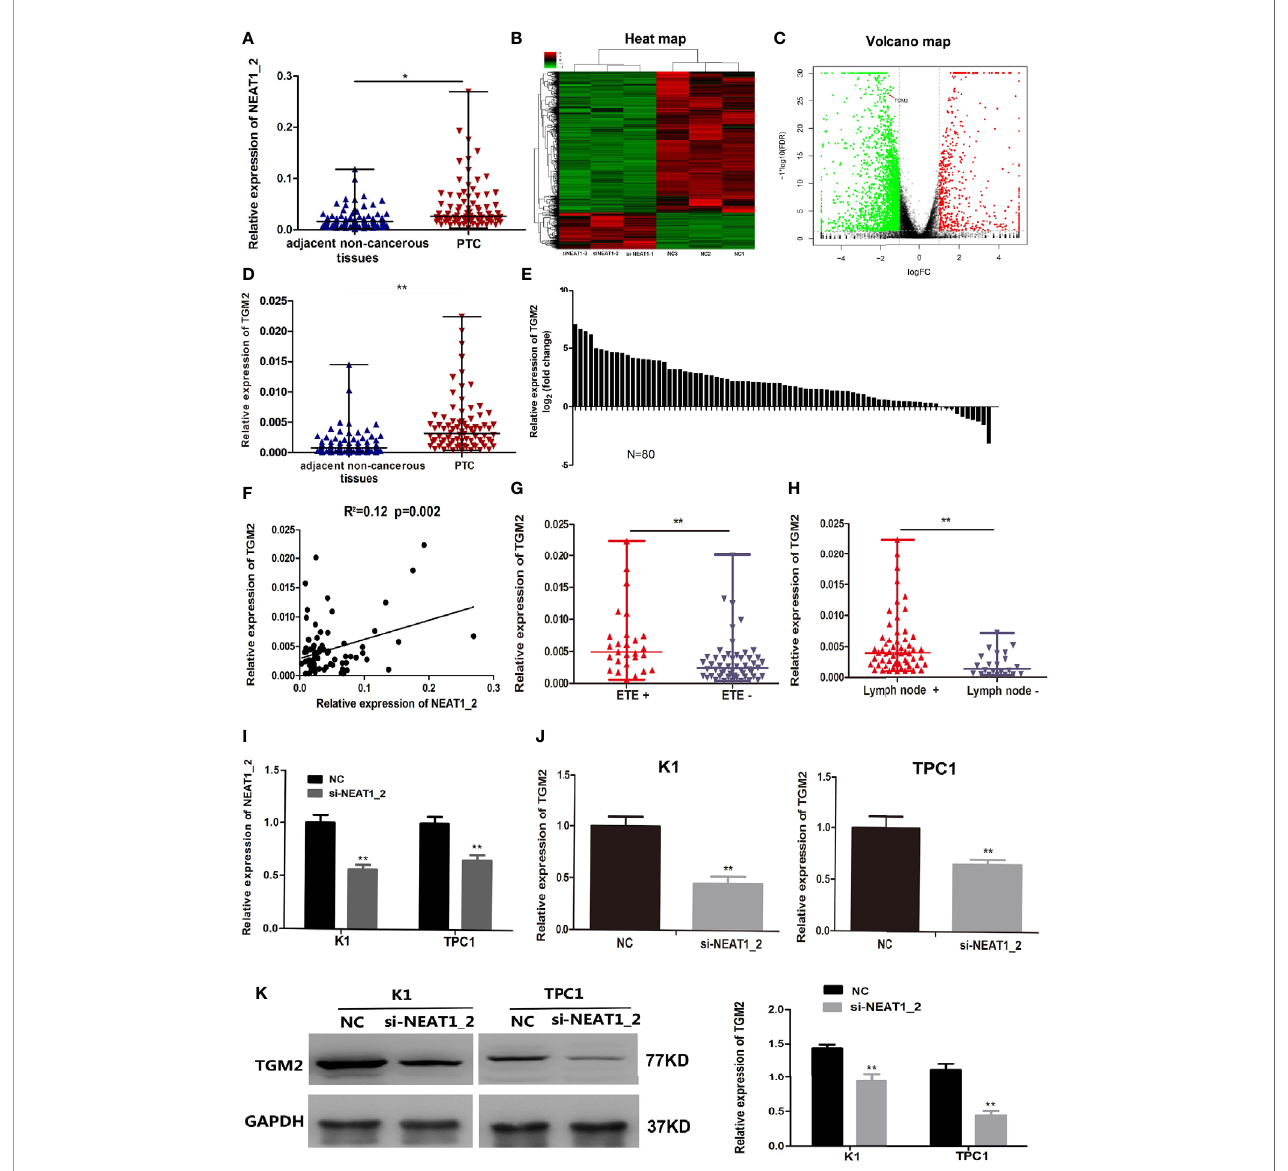
FIGURE 1 | NEAT1_2 expression was high and could regulate TGM2 in PTC. (A) The relative expression levels of NEAT1_2 in 80 pairs of PTC tissues and adjacent non- cancerous tissues, as determined using qRT-PCR. The Wilcoxon signed-rank test was used to analyzed the differences between the two groups; data are presented as the median with a range. *P < 0.05. (B) Heat map of differentially expressed mRNAs (615 upregulated and 2364 downregulated) in K1 cells transfected with si-NEAT1_2 and NC. (Fold change ≥ 2, P < 0.05). (C) Volcano plots were constructed based on the sequencing results of the differentially expressed mRNAs between K1 cells transfected with si-NEAT1_2 and NC. The red points represent differentially upregulated genes, and green points represent downregulated genes (Fold change ≥ 2, P < 0.05). A red arrow indicates TGM2 in the plots. (D) The relative expression levels of TGM2 in 80 pairs of PTC tissues and adjacent non-cancerous tissues, as determined using qRT-PCR. The Wilcoxon signed-rank test was used to analyzed the differences between the two groups; data are presented as the median with a range. **P < 0.01. (E) The fold change of TGM2 expression between PTC and corresponding adjacent non-cancerous tissues. (F) Pearson ’ s correlation analysis was performed to analyze the correlations between NEAT1_2 and TGM2 expression in PTC tissues (R 2 = 0.15, P < 0.05). (G) TGM2 expression in the extrathyroidal extension positive (n = 27) and extrathyroidal extension negative (n = 53) subgroups The Mann-Whitney U test was used to analyze the differences between the two groups; data are presented as the median with a range. **P < 0.01. (H) TGM2 expression in the lymph node metastasis positive (n = 58) and lymph node metastasis negative (n= 22) groups. The Mann-Whitney U test was used to analyze the differences between the two groups; data are presented as the median with a range. **P < 0.05. (I) qRT-PCR analysis of NEAT1_2 interference ef fi ciency after si-NEAT1_2 or NC transfection in PTC cells. **P < 0.01 versus NC. (J) The relative mRNA expression of TGM2 was detected using qRT-PCR in PTC cells after transfection with si-NEAT1_2 or NC. Data are presented as the mean ± S.D., as analyzed using an independent samples t-test. **P < 0.01 versus NC. (K) Western blotting was applied to detect the protein level of TGM2 in PTC cells transfected with si-NEAT1_2 or NC. Data are presented as the mean ± S.D., as analyzed using an independent samples t-test. **P < 0.01 versus